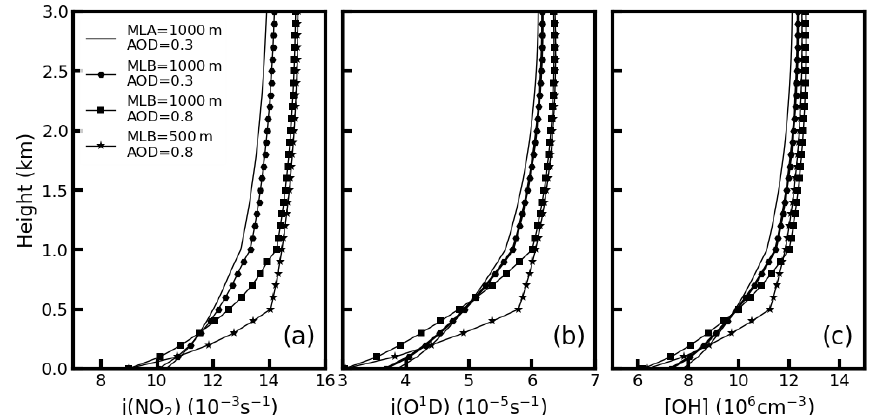
Figure 5. The estimated (a) j (NO 2 ), (b) j (O 1 D), and (c) OH concentrations for different aerosol profiles. The (1) solid line, (2) solid line marked with hexagons, (3) solid line marked with squares, and (4) solid line marked with stars represent the aerosol distribution of B1, B2, B3, and B4, respectively. Table 2. Details of the aerosol optical profiles and estimated photolysis values. Profile Type a Altitude b AOD k [ J (NO 2